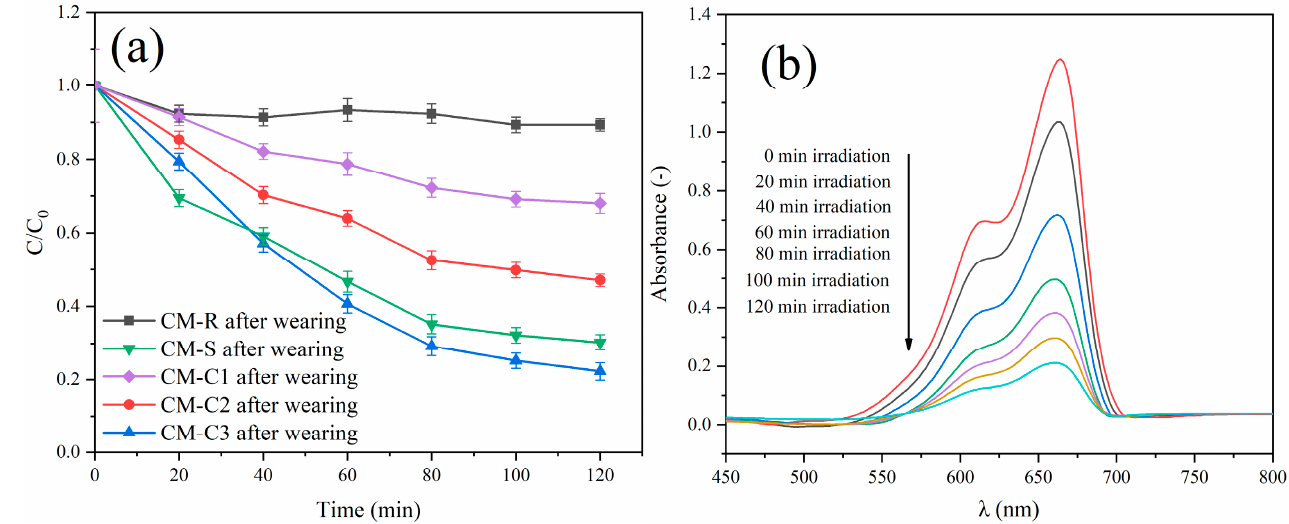
Figure 7. Photocatalytic measurements: ( a ) the MB removal ratio curves of the mortar samples after wearing; ( b ) absorbance spectra of MB degradation with UV-visible irradiation time for CM-C3. Table 2. MB removal ratio of mortar samples before and after wearing.